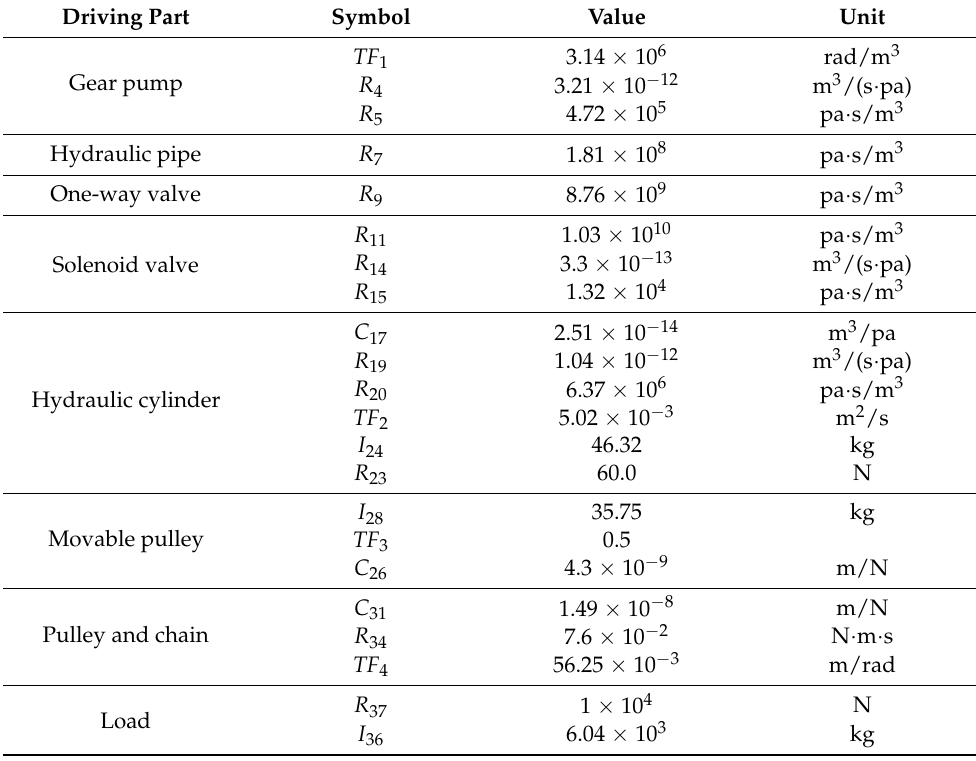
Table 2. The system parameters of HTD.